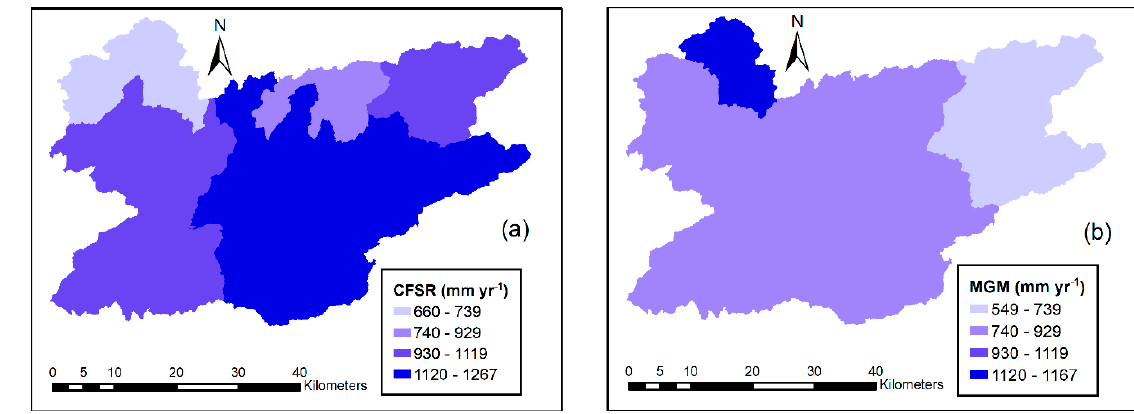
Figure 6. Spatial distribution of annual precipitation for CFSR ( a ) and MGM ( b ) datasets.